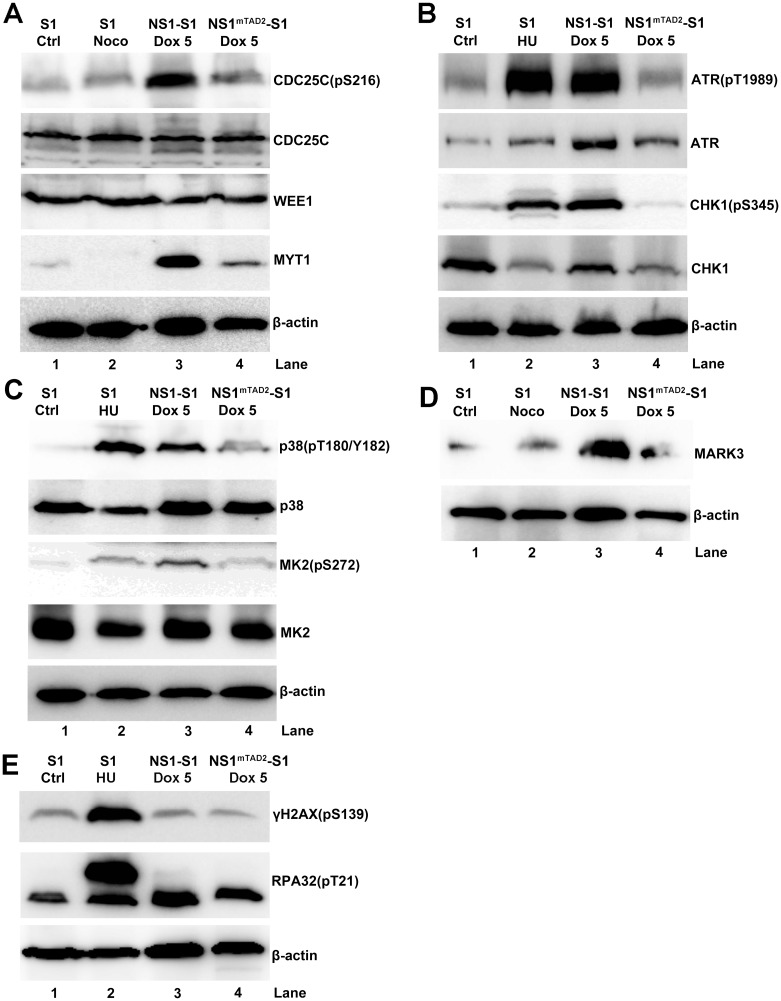
The NS1 TAD2 domain is responsible for transactivation of various cell cycle related genes.NS1-S1 and NS1mTAD2-S1 cells were induced by Dox (5 μg/ml) for 72 h. The cells were then collected, lysed, and immunoblotted with the indicated antibodies in each panel (A-E). S1 cells and S1 cells treated with Noco or HU were loaded as controls. β-actin was used as a loading control.